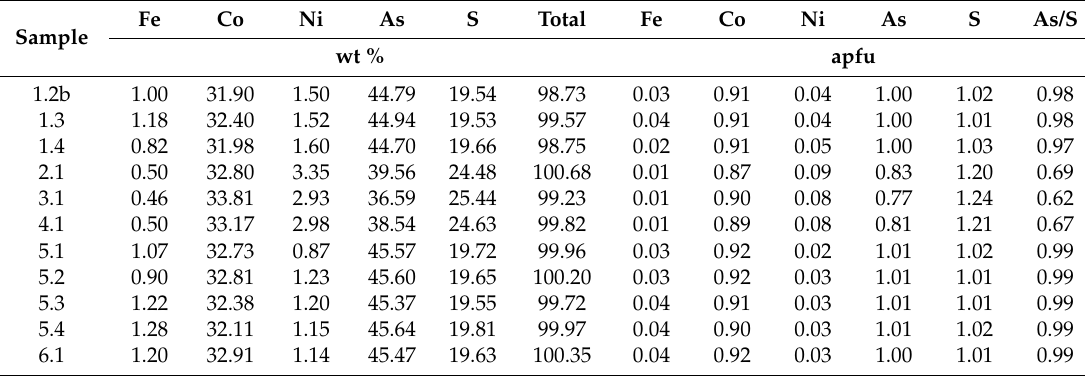
Table 2. Representative EPMA data and atomic proportions of